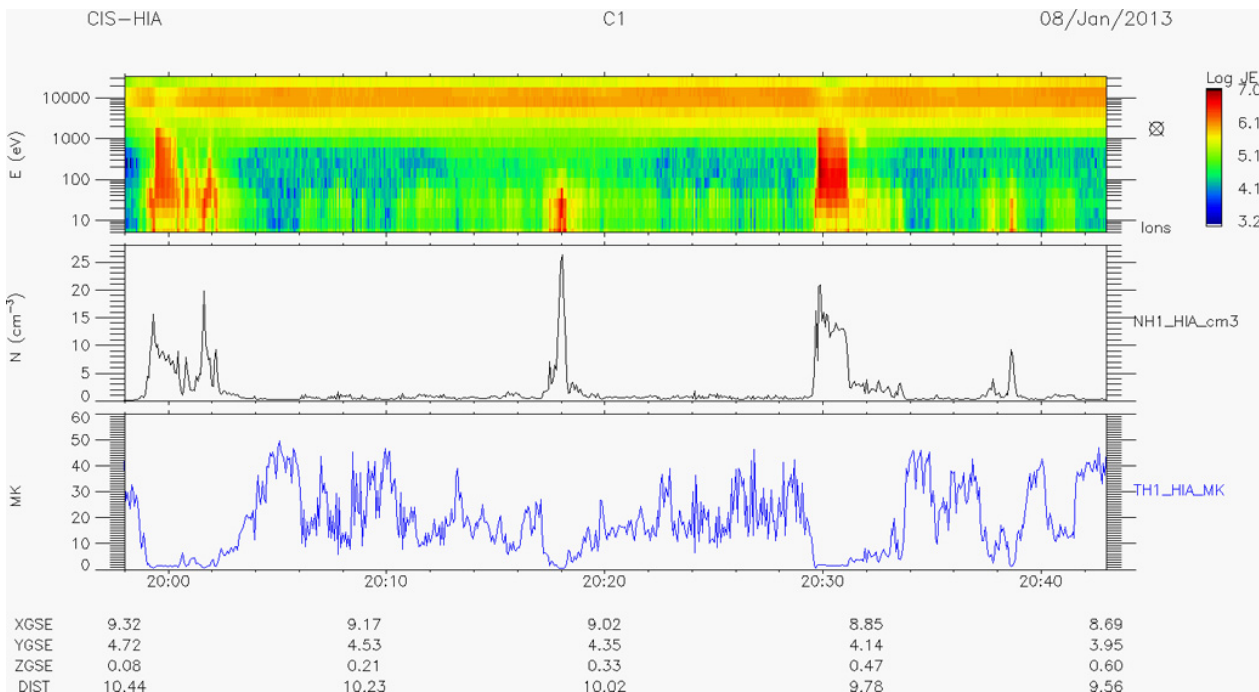
Fig. 10. Cluster C1 data obtained in the dayside outer magnetosphere on 8 January 2013, after a prolonged period of very quiet magnetospheric conditions. From top to bottom: HIA omnidirectional ion energy–time spectrogram in particle energy flux units (keVcm − 2 s − 1 sr − 1 keV − 1 ); ion density measured by HIA in particlescm − 3 ; ion temperature in MK; spacecraft coordinates in the GSE